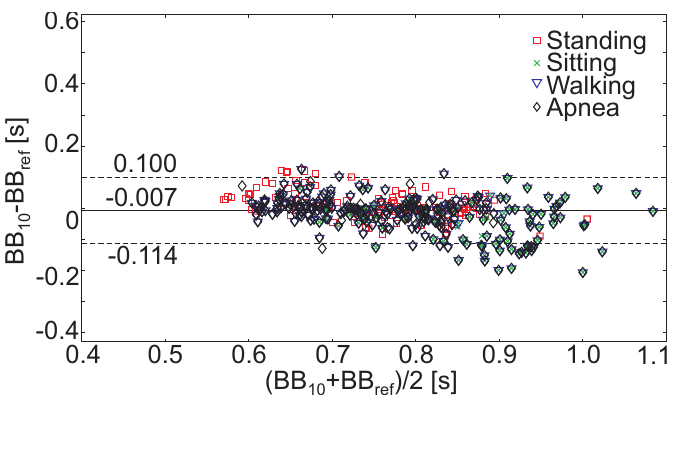
Figure 11. Bland–Altman plot of the beat-to-beat intervals, BB MAIN Shirt and the reference sensor, respectively, during different postures and